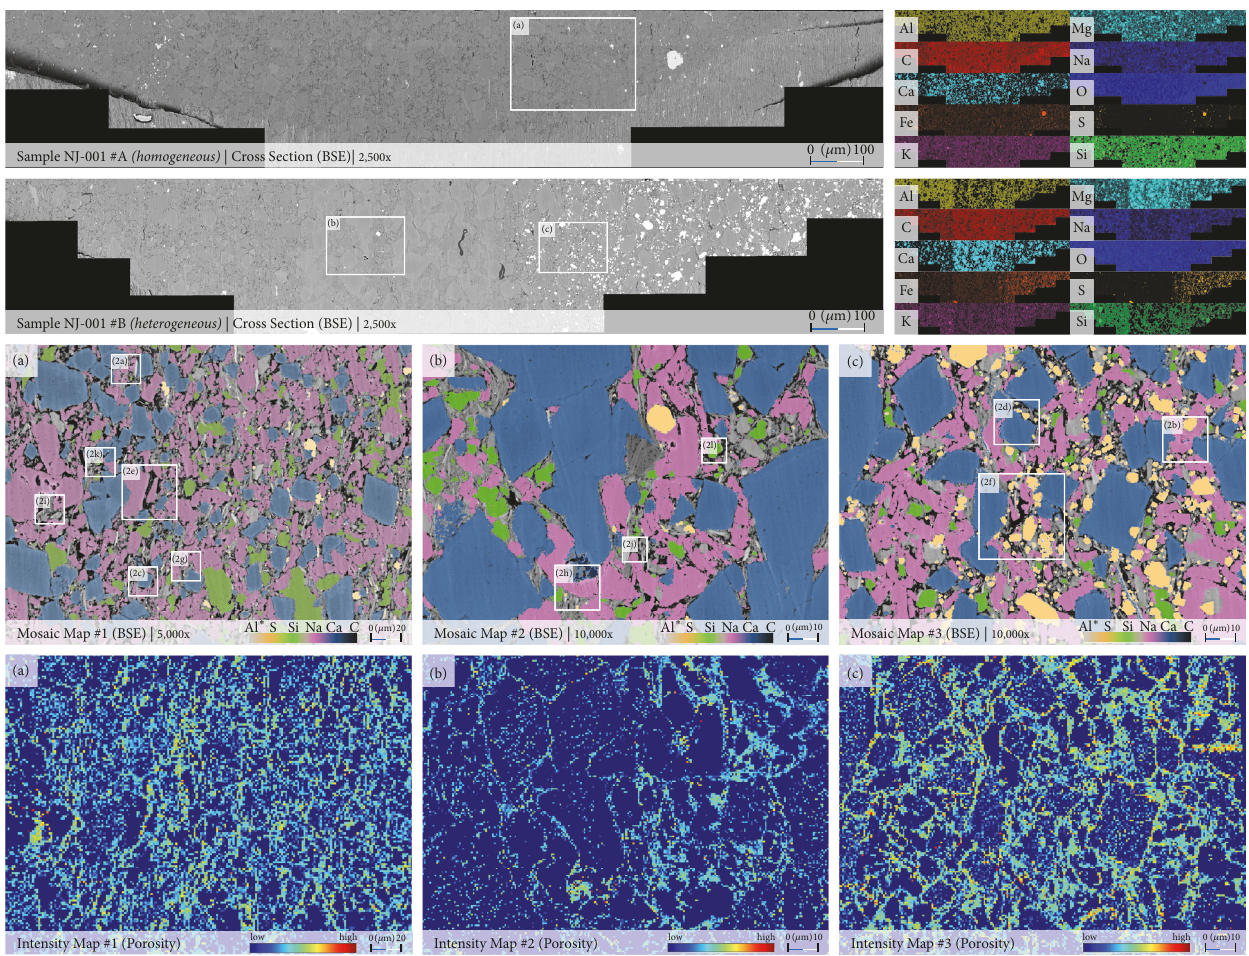
Intensity Map #1 (Porosity) Intensity Map #2 (Porosity) Intensity Map #3 (Porosity) 0 20